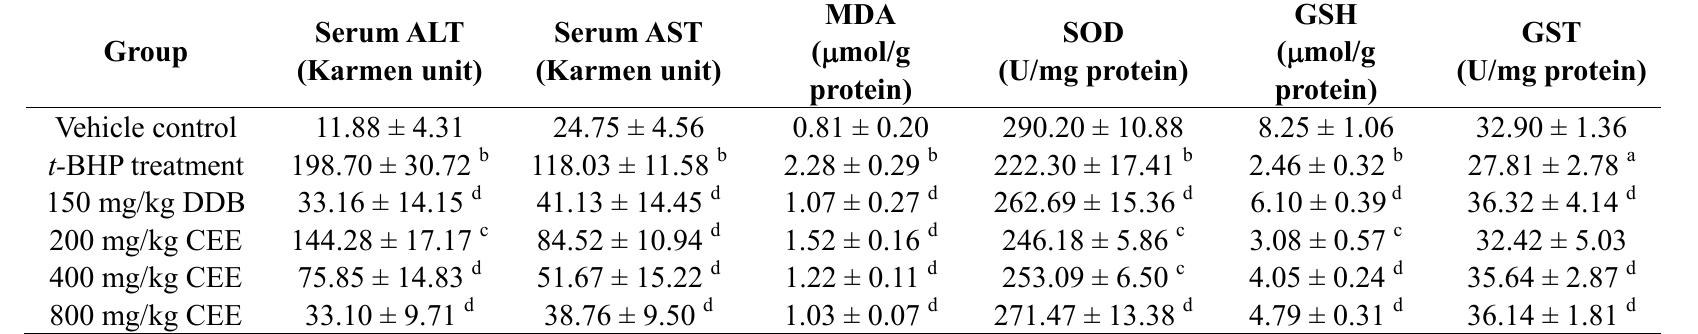
Table 1. Effect of CEE on t-BHP-induced hepatotoxicity in mice